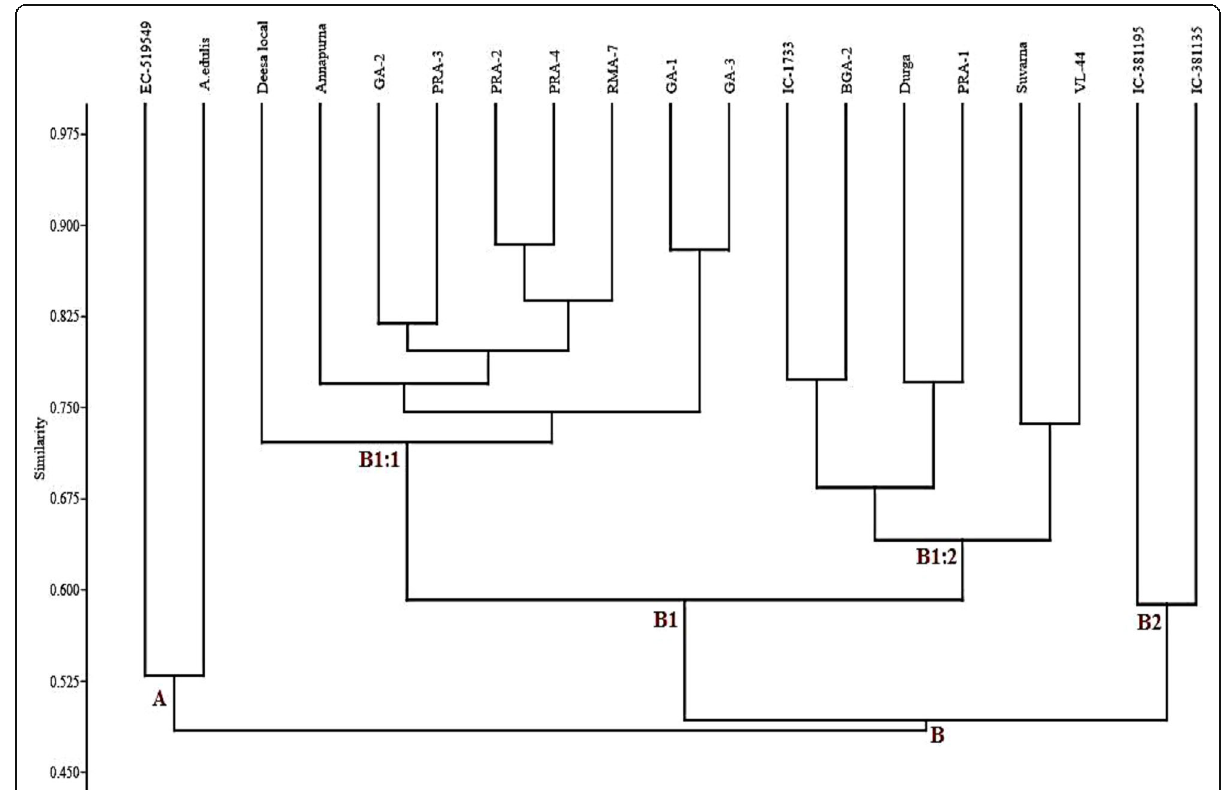
Fig. 2 UPGMA-based dendrogram of grain amaranth